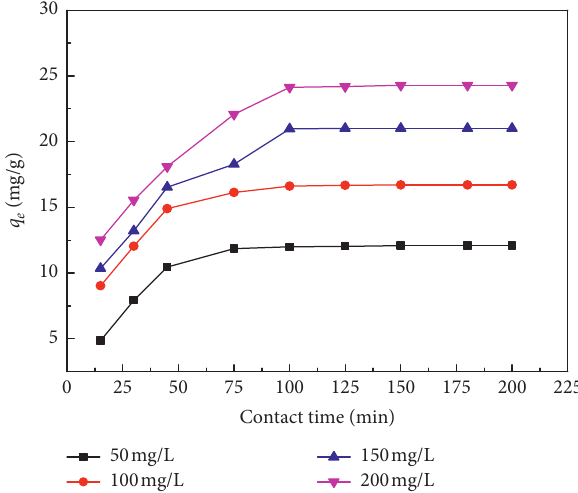
Figure 3: Effect of contact time on ammonium adsorption